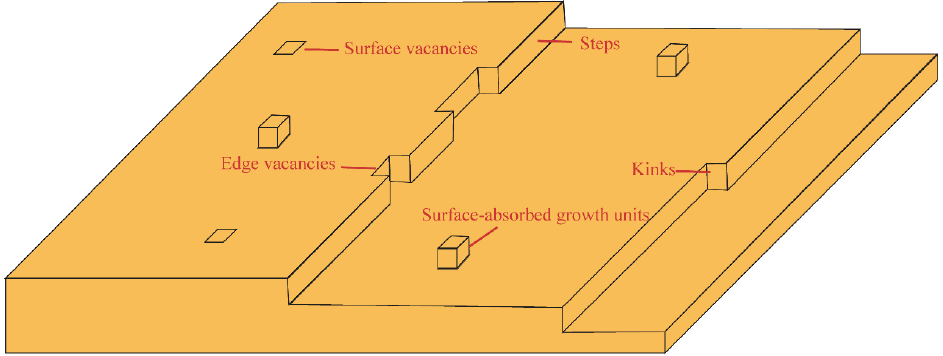
Figure 6. Schematic diagram of two-dimensional nucleation growth theory.